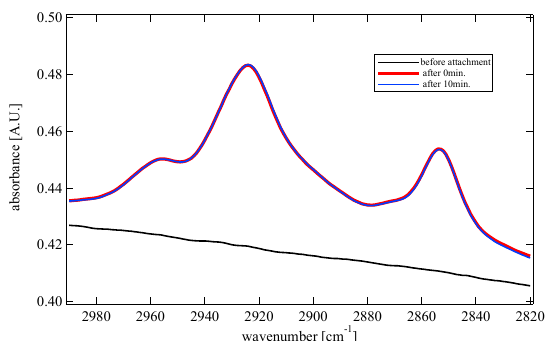
Figure 3. IR absorption spectrum of HNL before and after the fingerprint attachment. No absorption was detected before the attachment though obvious absorption peaks appeared after the attachment and kept themselves unchanged during the blurring shown in Figure 2.